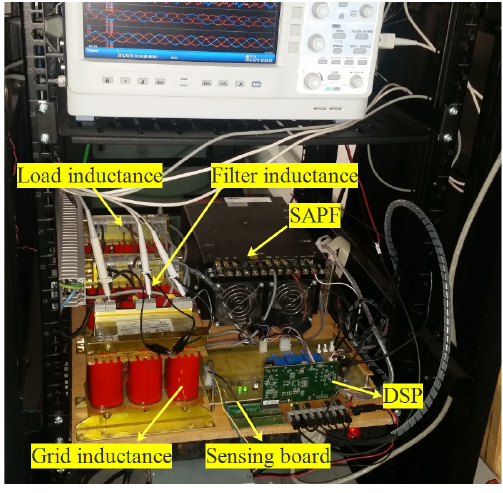
Figure 5. SAPF prototype. Table 3. System